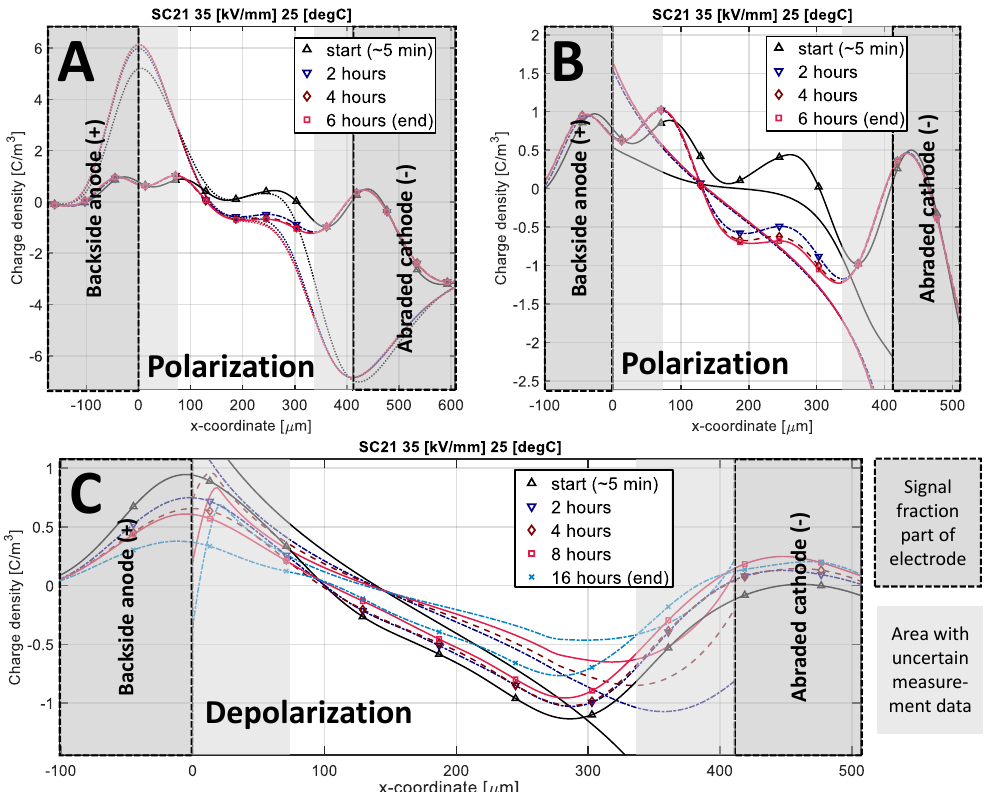
Figure 11. Line plots showing the measurement data before and after Gaussian peak removal ( A ). Line plots comparing net charge density in model and measurement during polarization ( B ) and depolarization ( C ). The lines with markers indicate measurements whereas the lines without markers indicate model results. Dotted lines indicate the original signal with induced electrode charges during polarization which were removed for better model measurement comparison, as further described in part I of the paper.